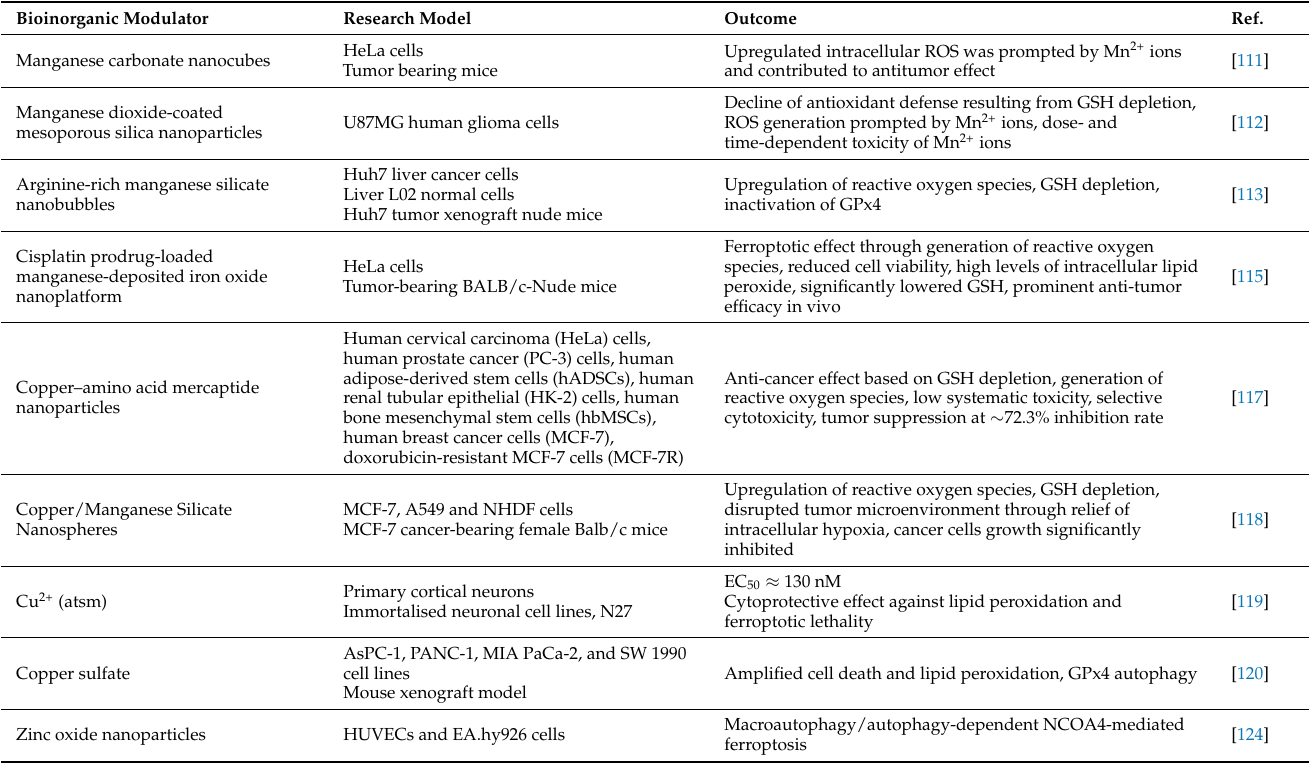
Table 3. Recapitulation of the transition metal-based compounds and their modulatory effect on ferroptosis-related cell survival and